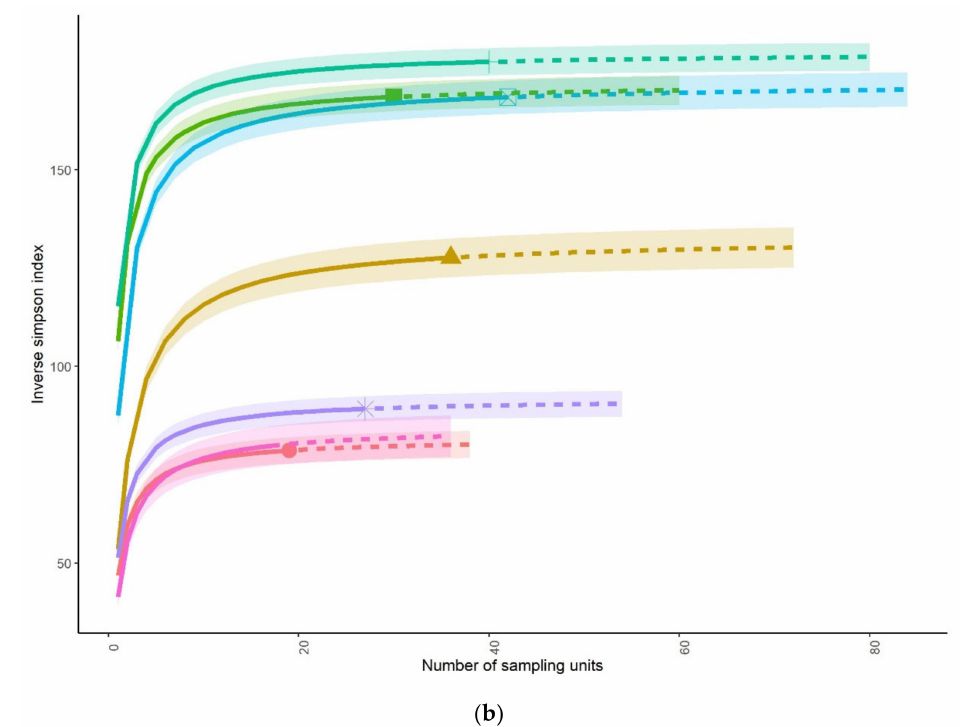
Figure 3. Rarefaction curves on ( a ) fish species richness of seven groups and subgroups, and ( b ) inverse Simpson diversity index of seven groups and subgroups. All extrapolation curves are plotted to a doubling in sample size, and 500 bootstrap replicates are used to estimate 95% confidence